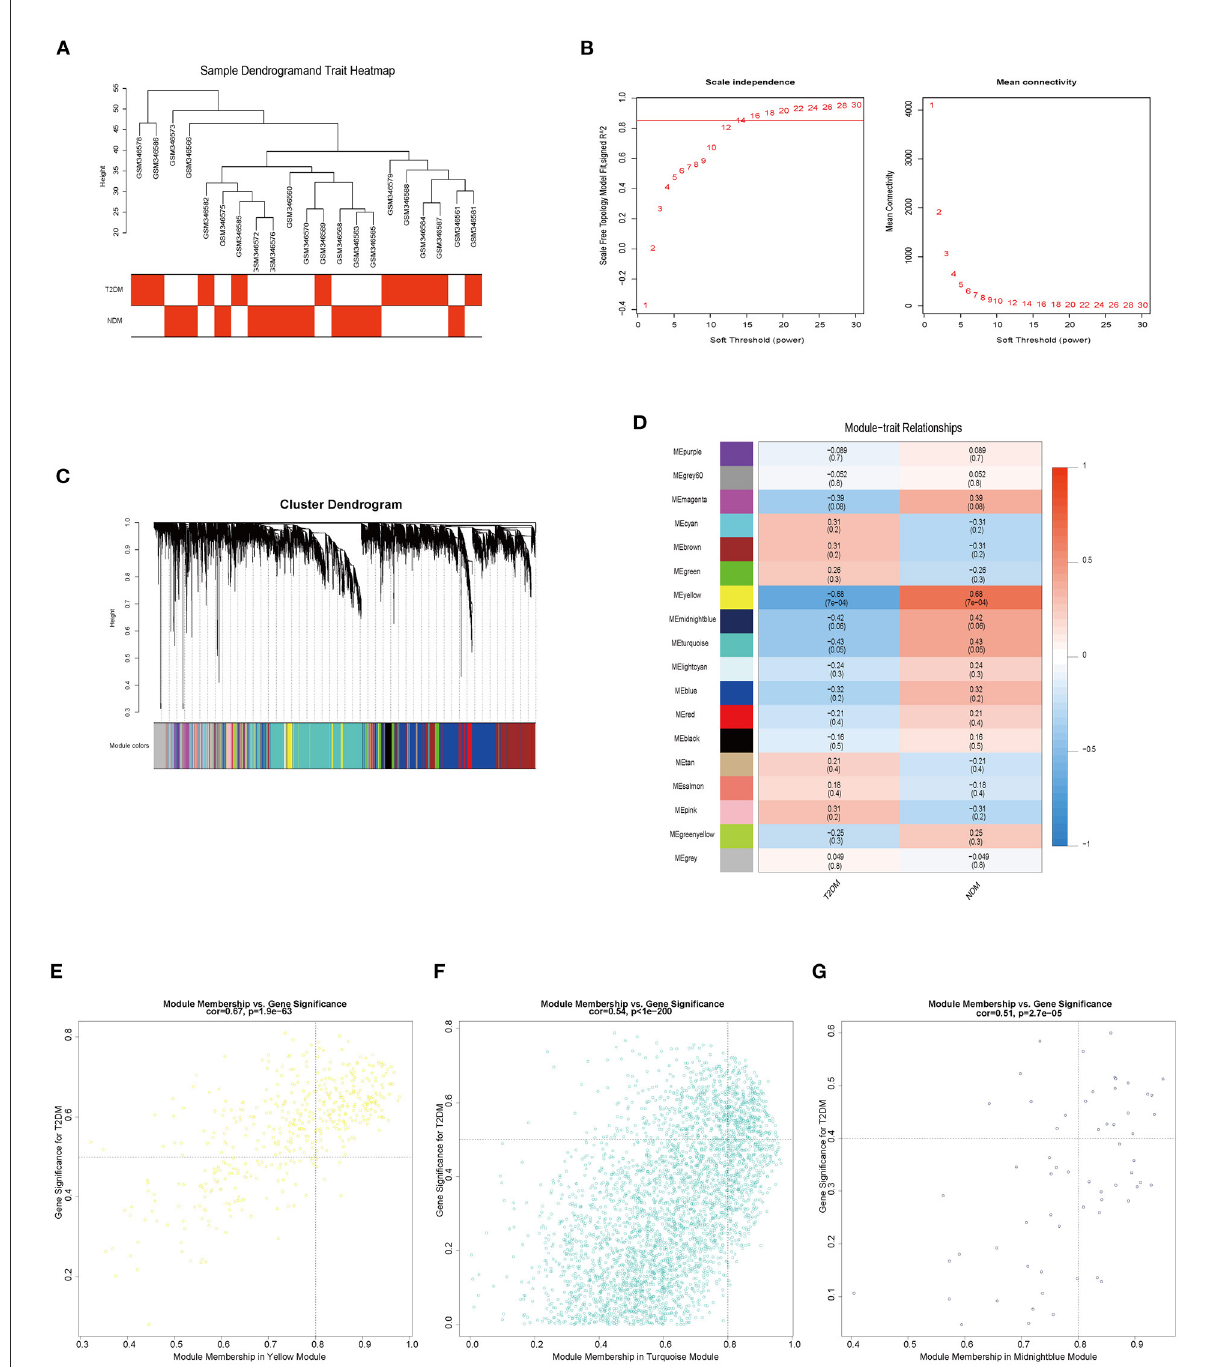
FIGURE4 The results of weighted gene co-expression network analysis (WGCNA). (A) Sample clustering and trait heatmap of GSE13760. (B) The relationship of soft threshold and scale independence or mean connectivity. (C) Cluster dendrogram and partitioned modules. (D) The eigengene adjacency heatmap of the correlation between modules and vascular endothelial cell dysfunction (VECD) of type 2 diabetes mellitus (T2DM). (E) The scatter plot of the yellow module eigengenes. (F) The scatter plot of the turquoise module eigengenes. (G) The scatter plot of the midnight blue module